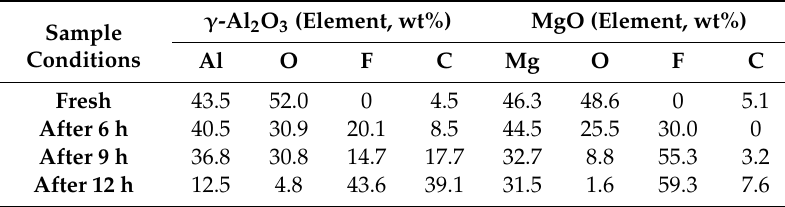
Table 3. EDS results for fresh and spent γ -Al 2 O 3 and MgO used in the serial bed configuration.